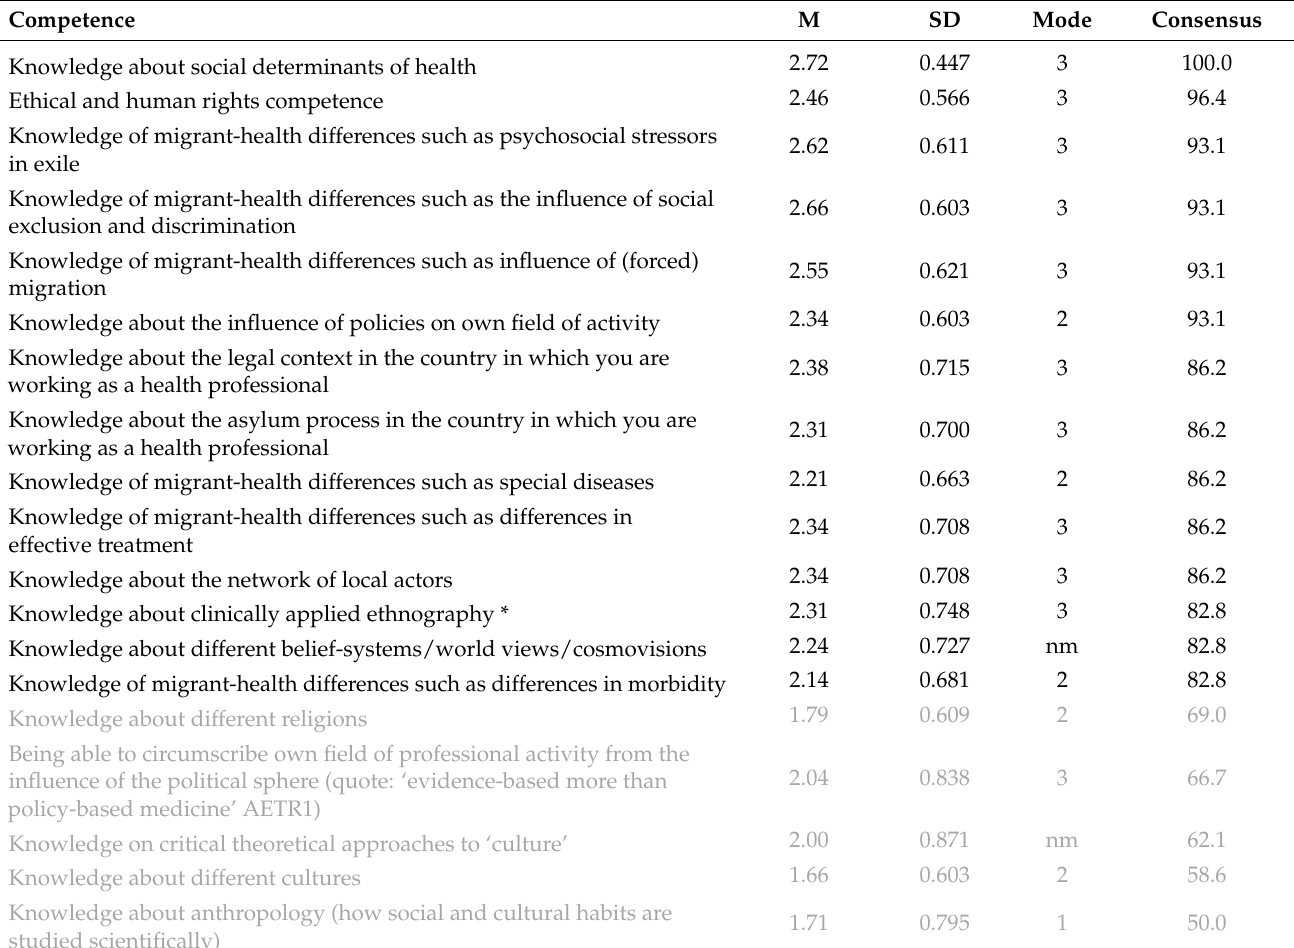
Table 5. Ranking according to consensus in the cognitive